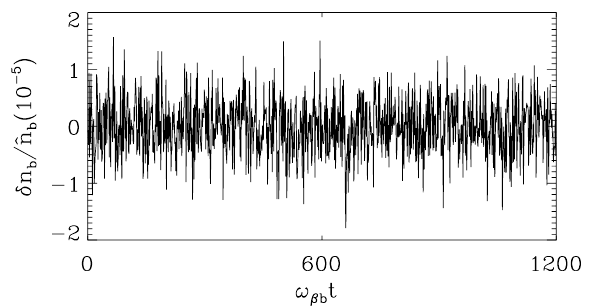
FIG. 1. Time history of d n b (cid:3) ˆ n b for small-amplitude perturba- tions about a thermal equilibrium ion beam.